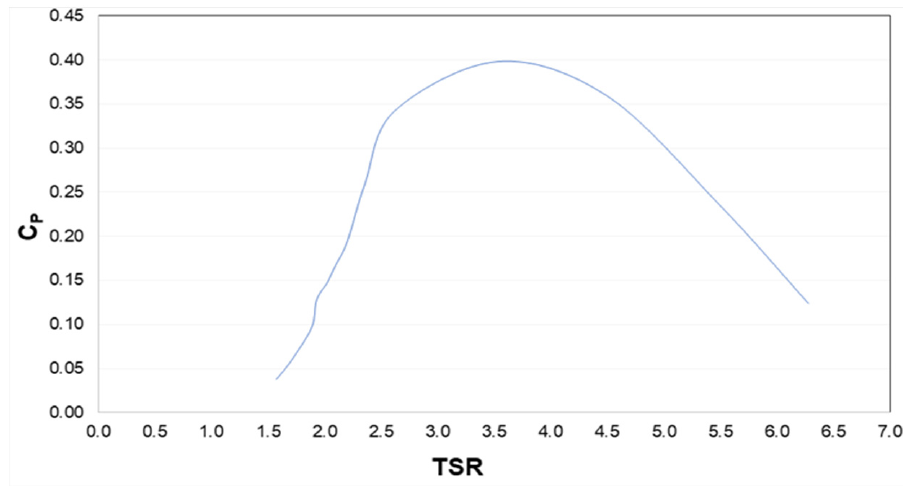
Figure 11. C P Vs. TSR for selected turbine design.